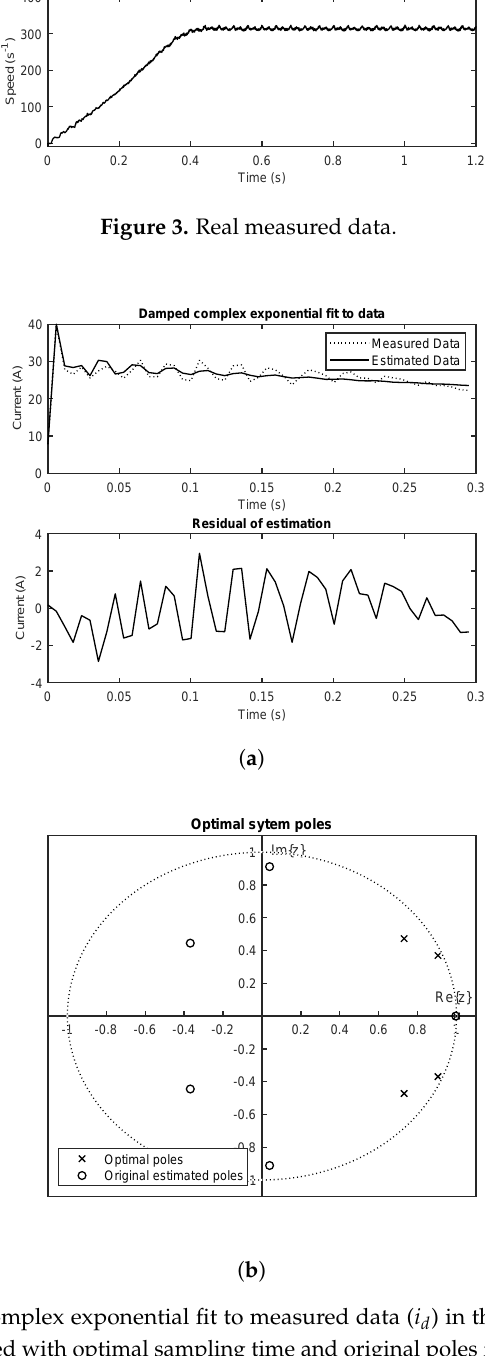
Figure 4. ( a ) Damped complex exponential fit to measured data ( i d ) in the 1st interval, with Γ = ˆ Γ ; ( b ) Optimal poles obtained with optimal sampling time and original poles from Prony